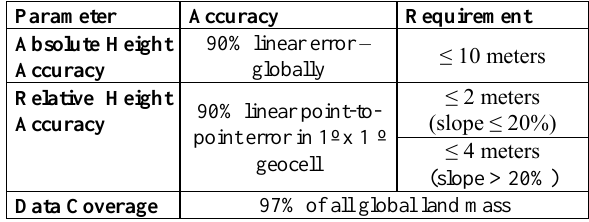
Table 1. TanDEM-X performance requirements